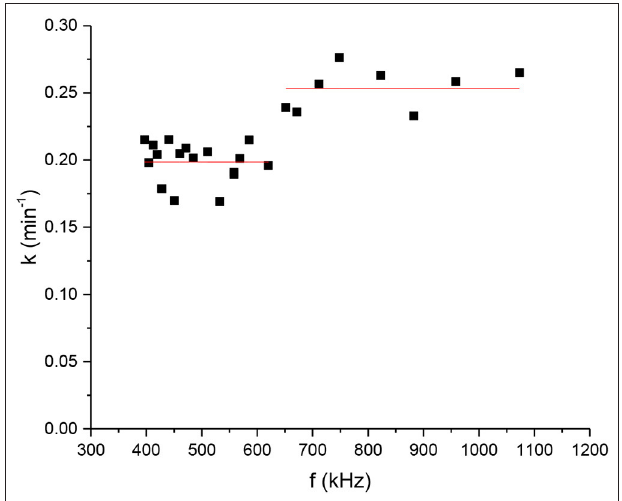
FIGURE 6 | Fitting parameter. of Equation 3n the data of Figure 3 vs. frequency.